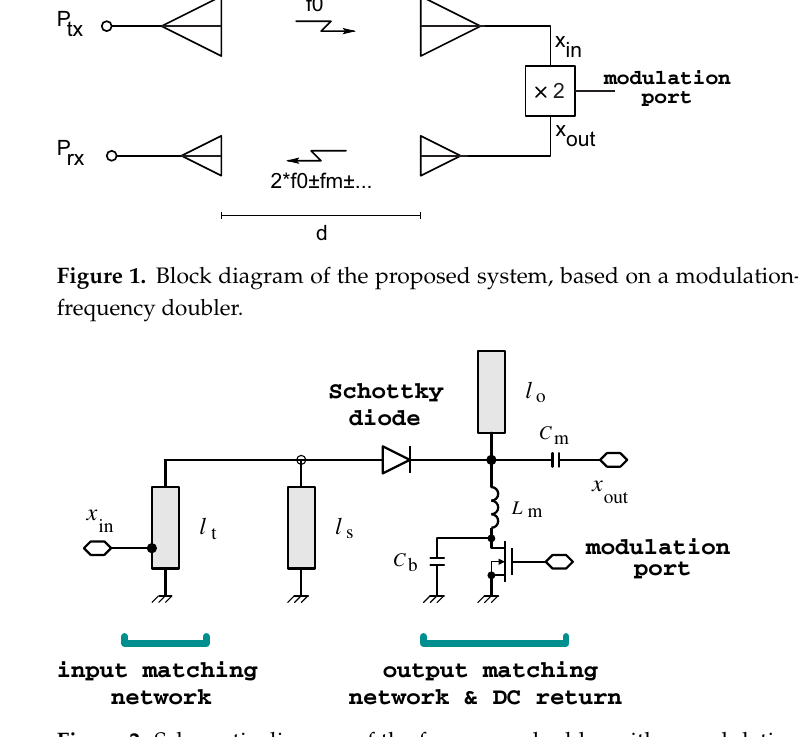
Figure 2. Schematic diagram of the frequency doubler with a modulation port. Main parameters: l t = 43 mm, l s = 50.5 mm, l o = 41 mm, L m = 6 nH, and C m = 1 pF. A BSS123 (ON-Semiconductors) MOS transistor is used to perform the OOK